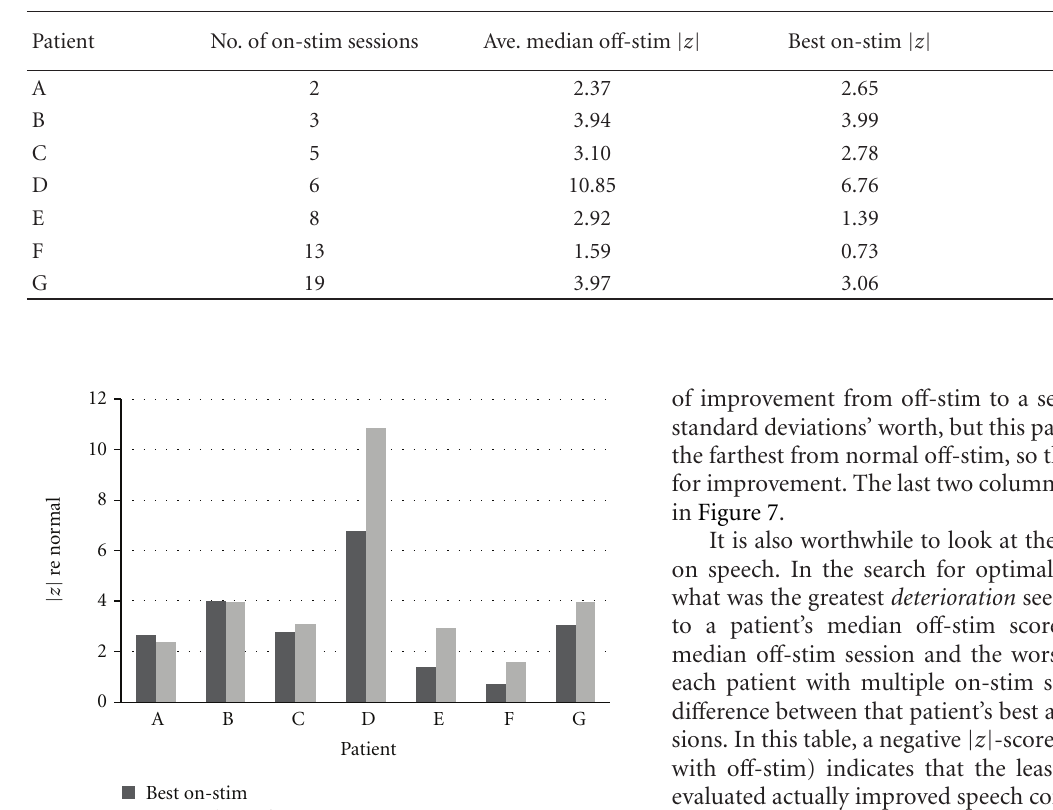
Table 8: Best e ff ect of DBS on speech.